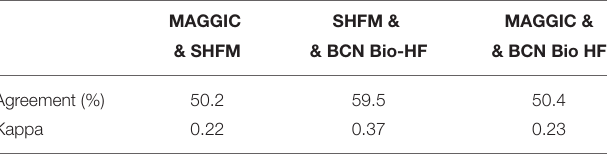
TABLE 5 | Agreement between calculators and Cohen’s kappa coefficients regarding increased risk of death after 1 year of